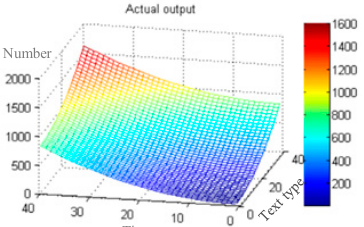
Figure 6. Actual data.